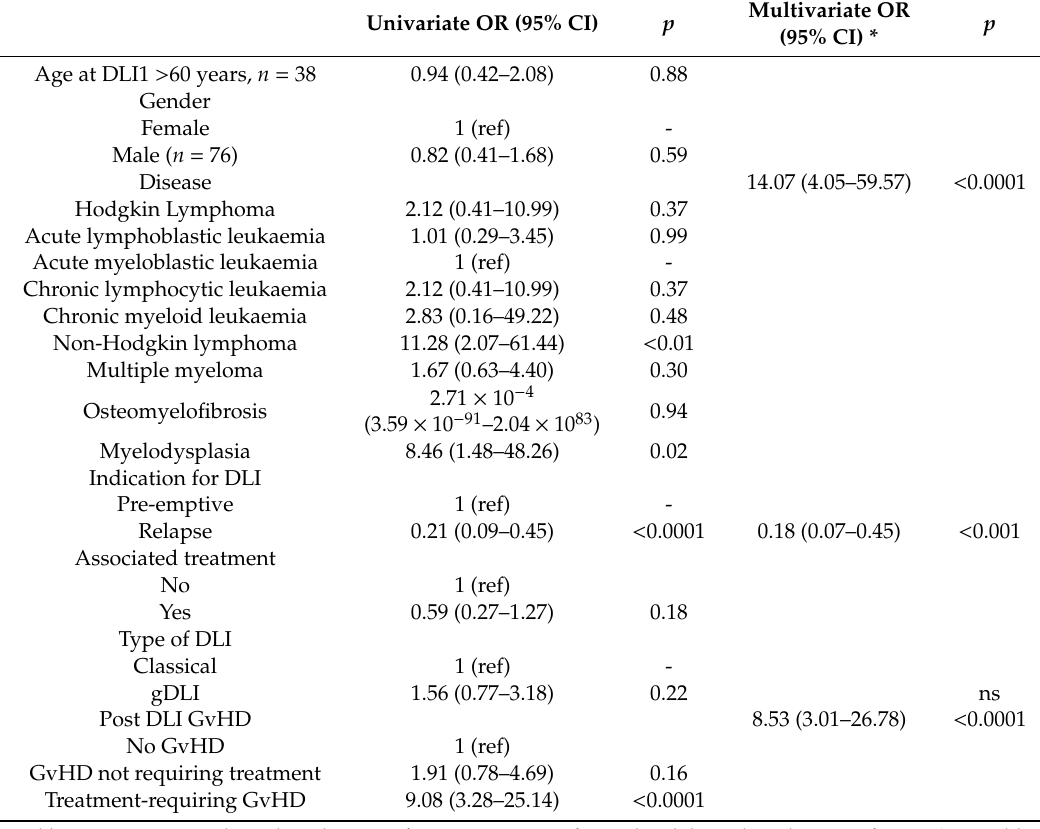
Table 4. Univariate and multivariate logistic regression response analysis to DLI treatment, n =